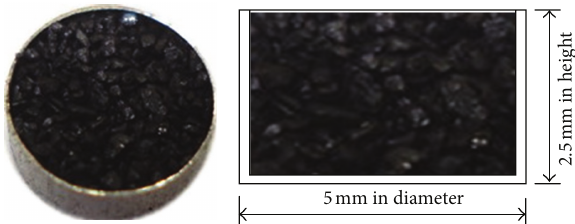
Figure 2: Coal sample in platinum container ( ≈ 30mg coal).